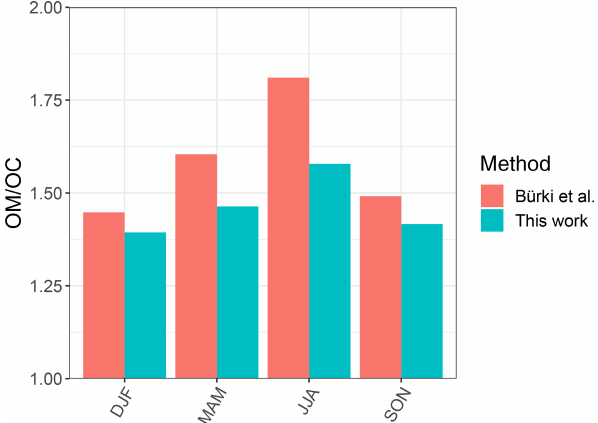
Figure 12. Bar chart showing median OM / OC ratio calculated for each season based on samples collected at the Phoenix, AZ, moni- toring site using our method and the one used by Bürki et al.